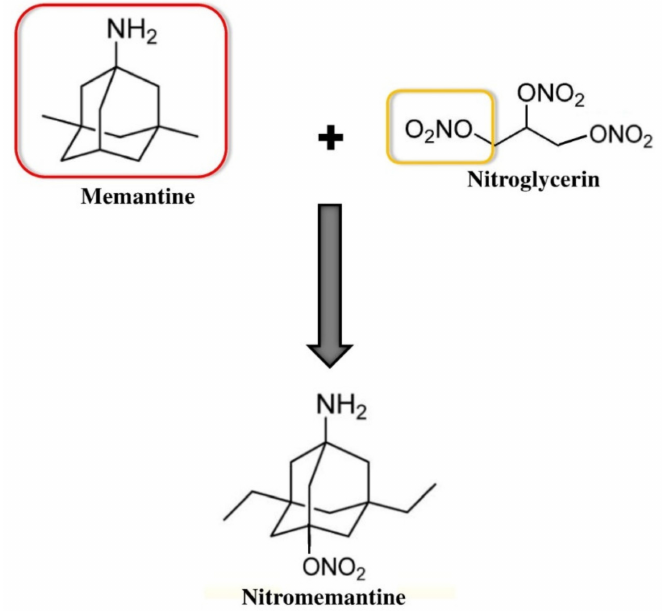
Figure 2. The linking of memantine and nitroglycerin leads to a new drug